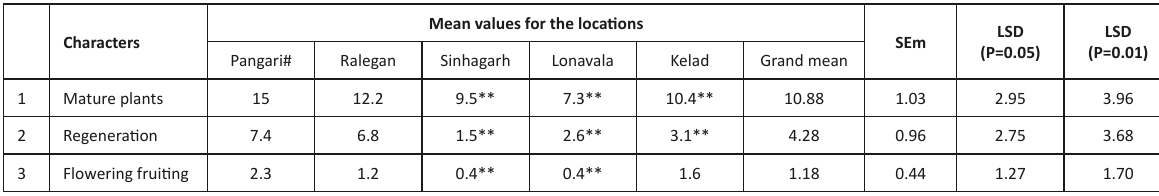
Table 3. The mean values for the locations (Treatments) along with standard